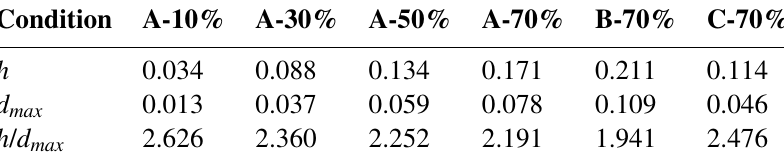
Table 8 Calculation results of h and dmax when k = Z =